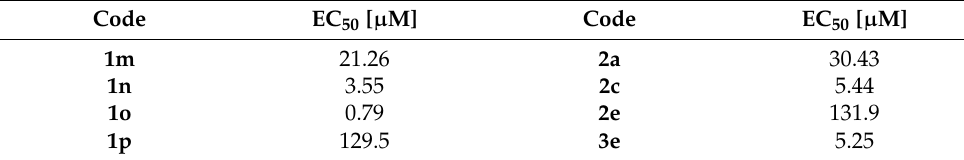
Table 6. Cytotoxicity of the selected derivatives 1 – 3 line using LDH release assay.